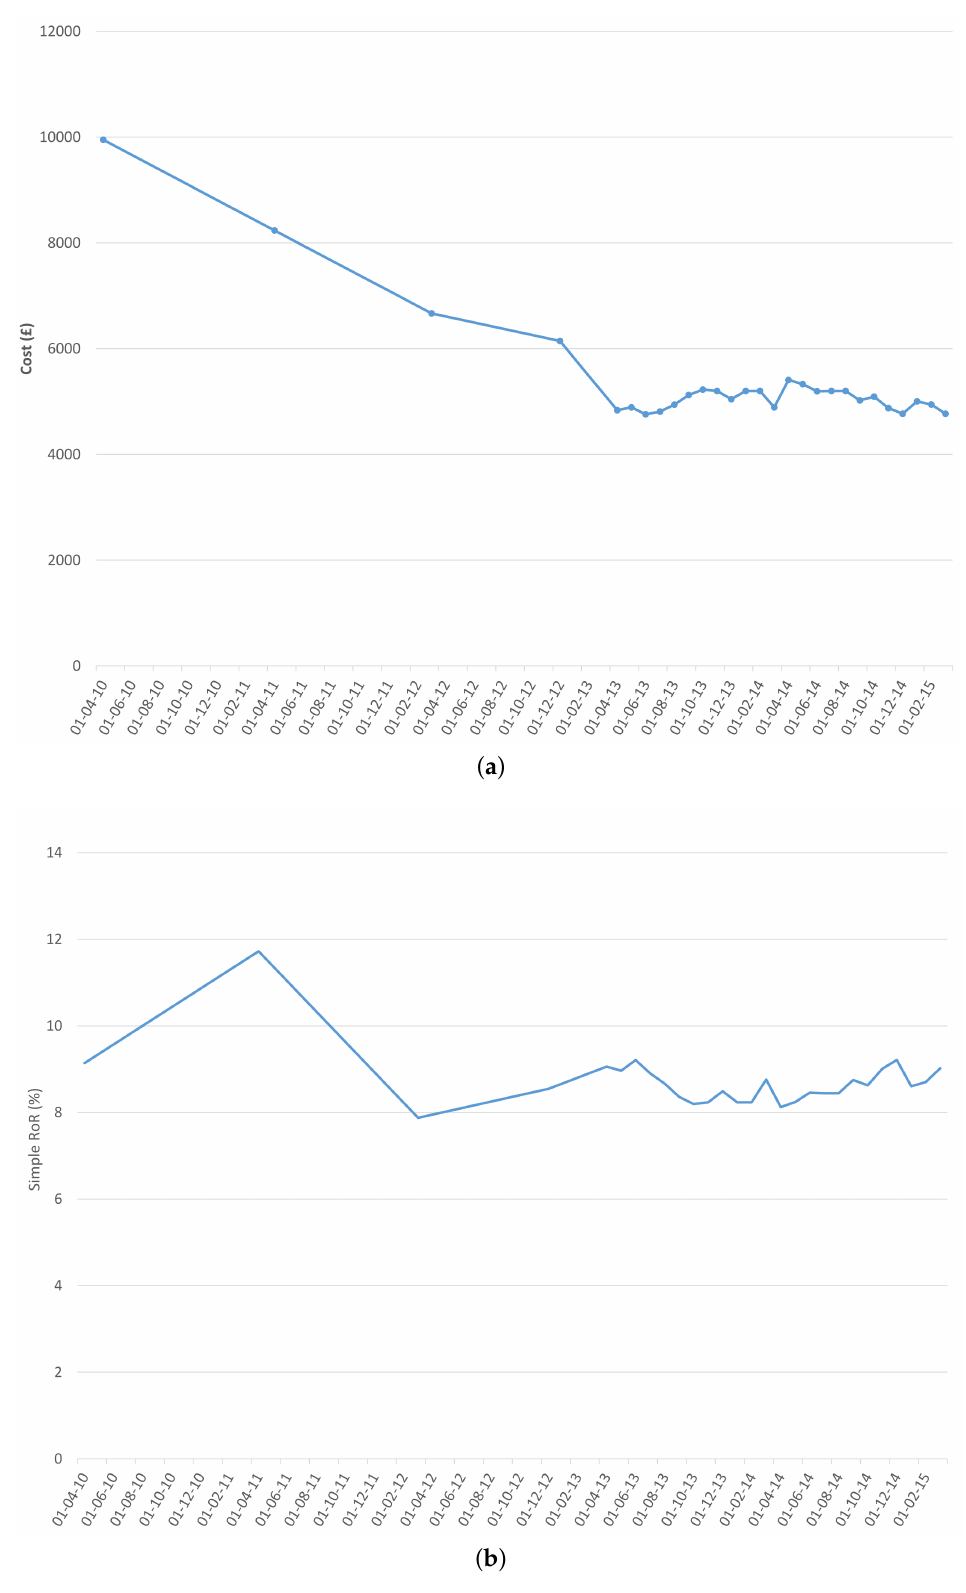
Figure 1. Cost of an installed 2.6-kWp PV system, feed-in tariff rate and rate of return for the installed system 2010–2015. ( a ) Installation cost of 2.6 kWp PV system; ( b ) Indicative rate of return for the 2.6 kWp reference system (assumed 1280 kWh/m 2 insolation, panel area 6 m 2 , load factor 10%). Data sources: cost [26] (2010 figure), [27] (2011 and 2012), [28] (2013–2015); feed-in tariffs,